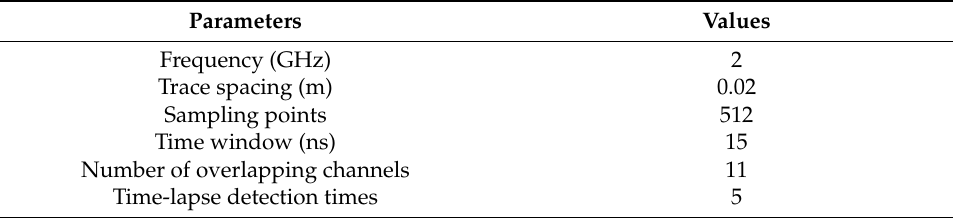
Figure 2. ( a ) Transmitter and receiver arrays of Mobyscan-V. It is divided into two systems, A and B, and each system contains eight pairs of transceiver antennas to form 15 data channels. The spacing between the two systems is 10 cm. ( b ) Layout of the survey lines. Four group lines were used to achieve full-coverage of the experimental area. Table 1. TLFC 3D GPR data acquisition